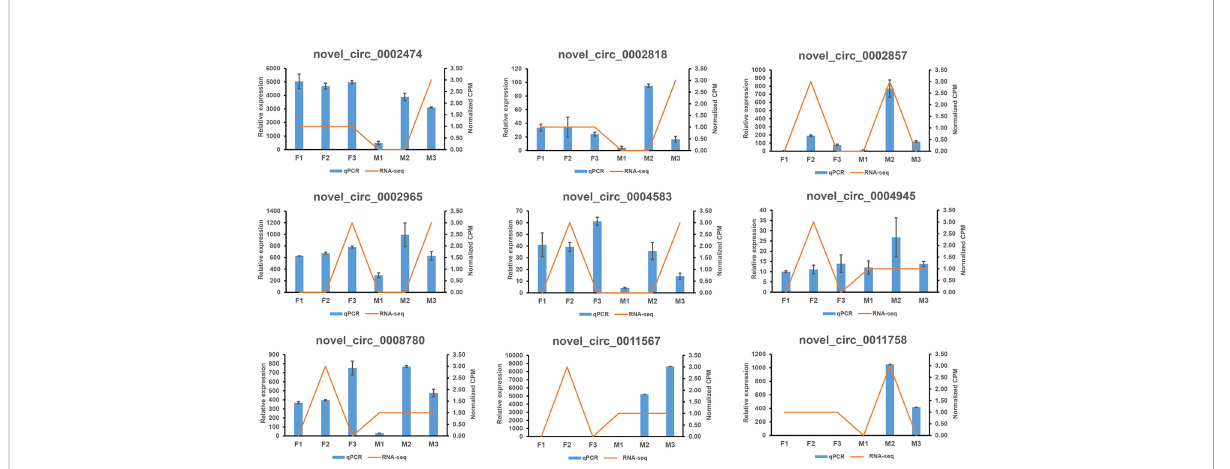
FIGURE 5 The comparison of real-time quantitative RT-PCR (qRT-PCR) and RNA sequencing (RNA-seq) for 9 circRNAs. The two results were in good agreement. The blue columns represented the results of the q RT-PCR, and the orange lines denoted for the results of the